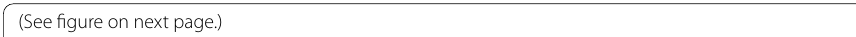
figure on next Fig. 3 Inhibition of mTOR affects ER-to-GA VSVg trafficking in human fibroblasts. a Representative time-lapse confocal images of living fibroblasts that were electroporated with Str-li_VSVGwt-SBP-EGFP and treated with INK128 (300 nM, 30 min) or untreated (control). Trafficking of VSVg-EGFP was visualized using the RUSH assay for 90 min after the addition of biotin (time 0). Scale bar 20 µm. b Quantitative analysis of the = experiments performed as in ( a ). The graph presents VSVg-EGFP fluorescence intensity in the Golgi apparatus region at each time point, normalized to the maximum value. The data are expressed as the mean for all of the analyzed cells. Error bars indicate SEM. N 3 independent experiments. Number of cells per variant = ( n ): Untreated (51), INK128 (42). c Comparison of VSVg-EGFP fluorescence intensity in the Golgi apparatus region at 38 min. The data are expressed as the mean for all of the analyzed cells. Error bars indicate SEM. * p < 0.05 (Mann–Whitney test). The number of independent experiments and analyzed cells per variant are the same as in ( b ). d Representative confocal images of fibroblasts that were electroporated with Str-li_ VSVGwt-SBP-EGFP (green) and immunofluorescently stained for the cis -Golgi marker GM130 (magenta). Scale bar 20 µm. e Western blot analysis of phospho-AKT (P-AKT) and phospho-S6 (P-S6) levels in protein lysates = from control fibroblasts or fibroblasts after INK128 treatment (300 nM, 30 min). f Quantification of Western blot analysis of P-AKT and P-S6, normalized to tubulin, in protein lysates that were obtained from fibroblasts treated as in e . * p < 0.05, *** p < 0.001 (one-sample t -test). Number of independent experiments ( N ): P-AKT (2), P-S6